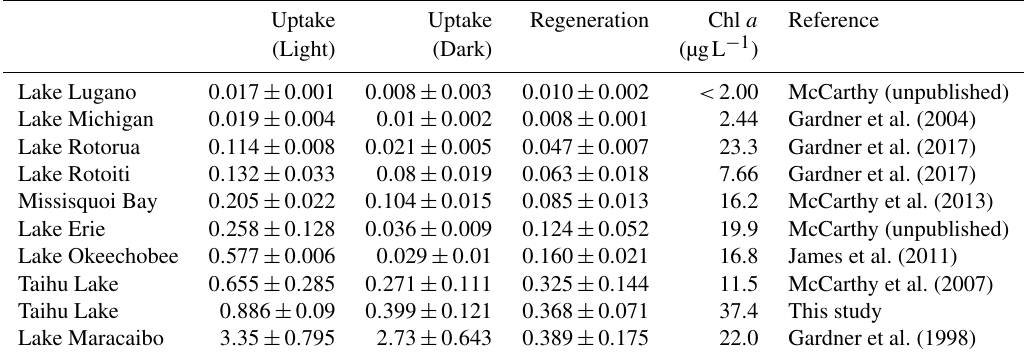
Table 3. Comparison of ammonium dynamics (in µmolL − 1 h − 1 ) and chlorophyll a concentrations among different freshwater studies. Uptake Uptake Regeneration Chl a Reference (Light) (Dark) (µgL − 1 ) Lake